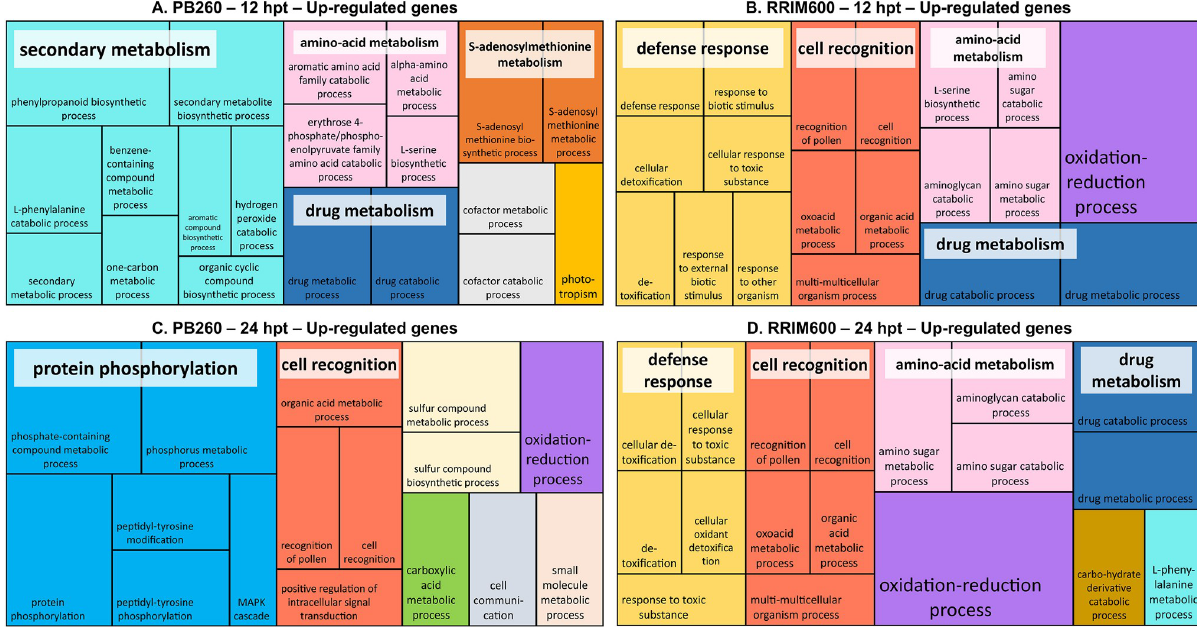
Fig 3. REVIGO treemap representation summarizing GO biological process categories over-represented among PB260 (A and C) and RRIM600 (B and D) up-regulated genes. Treemaps were performed separately for 12 hpt (A and B) and 24 hpt (C and D). They were built using the percentages of genes annotated with the non-redundant GO terms from S4 Table (REVIGO treemap % column). Each rectangle represents a significant GO term, sometimes joined into colorized superclusters of loosely related terms, whose names are labelled in white squares. The size of the rectangles is proportional to the p-value given by the Blast2GO analysis (i.e. the larger the rectangle, the more significant the